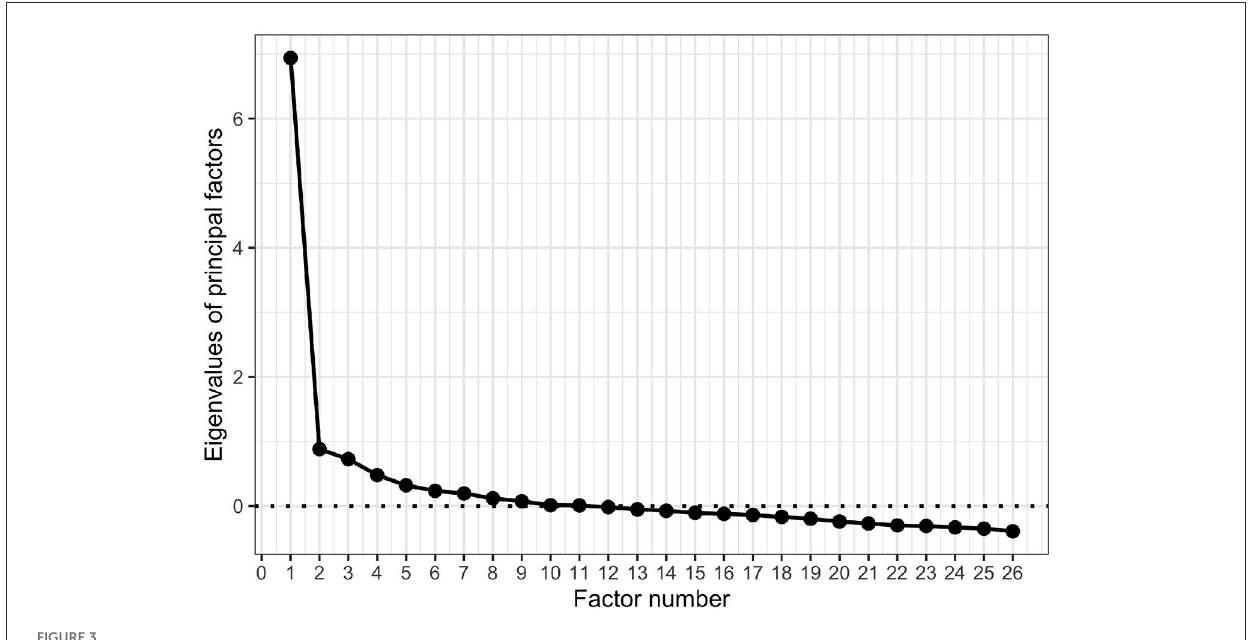
FIGURE3 Scree plot of eigenvalues in exploratory factor